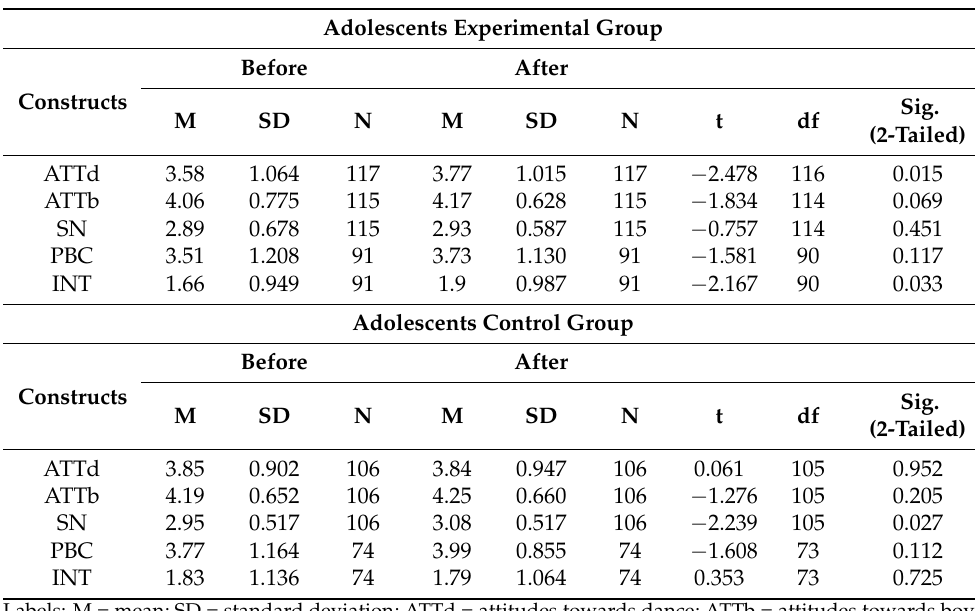
Table 5. Independent samples’ test results of children and adolescents: differences before and after the SMI—experimental group.